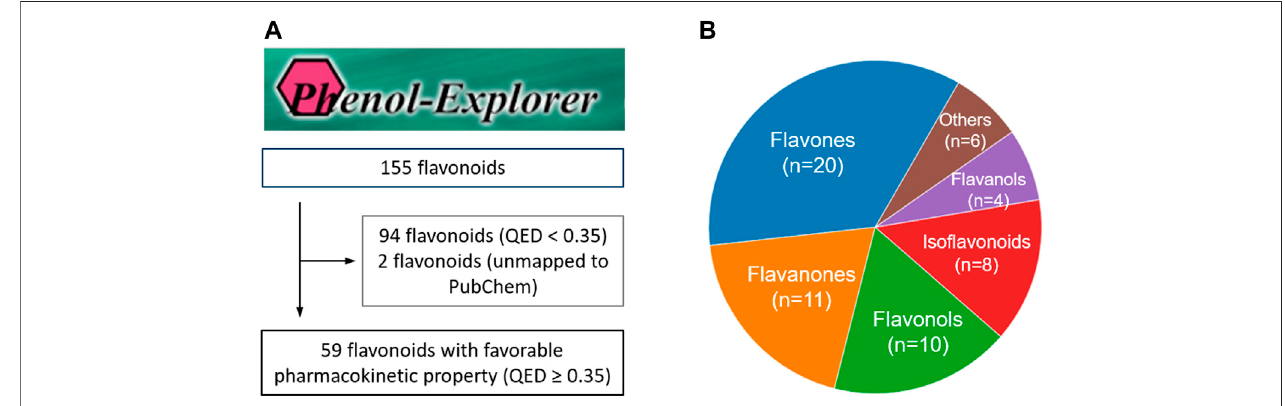
FIGURE 2 | Selection process for fl avonoids evaluated in this study and their chemical distribution. (A) The fl owchart of selecting the fl avonoids (B) Distribution of fl avonoids across its